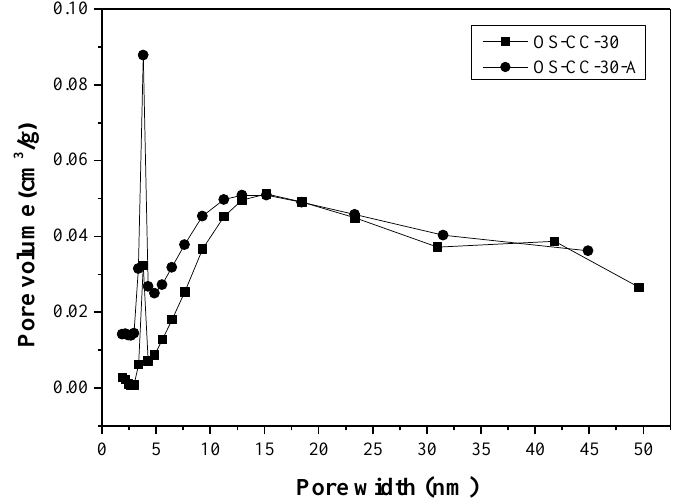
Figure 3. Pore size distributions for the CC products (i.e., OS-CC-30 and OS-CC-30-A).